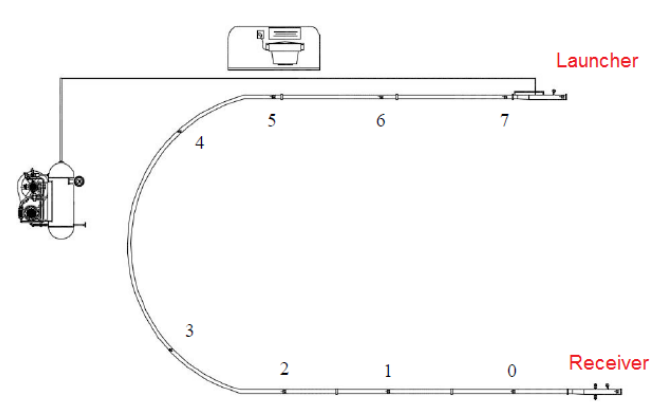
Figure 7. Positions of the pressure sensors along the pipeline. Source: By authors.